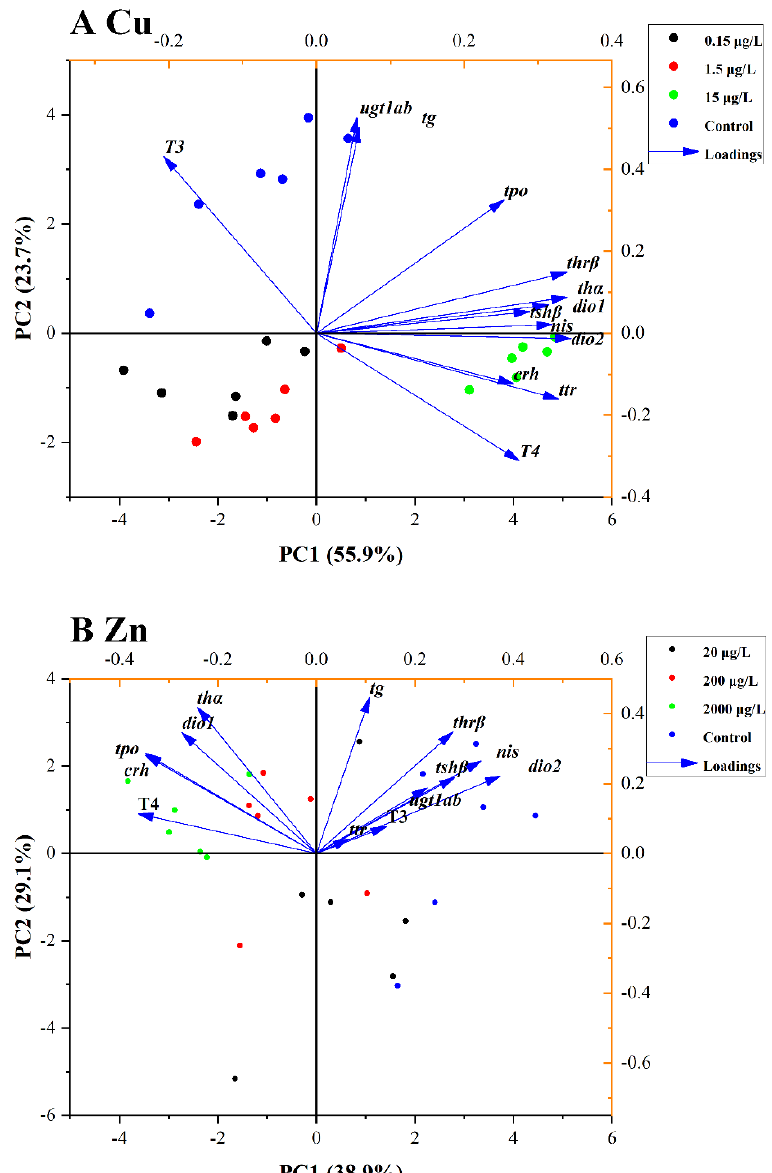
Figure 3. PCA of parameters in zebrafish embryos/larvae that were treated with Cu 2+ (0, 1.5, 15 and 150 µ g/L) ( A ) and Zn 2+ (0, 20, 200 and 2000 µ g/L) ( B ) for 120 h. The PCA result of Zn 2+ exposure is shown in Figure 3B. The initial two PCs explained 68.0% of the total variances. The PC1 accounted for 38.9% of the total variances, while PC2 explained 29.1% of the total variances. Based on the PCA result, the separation between clusters of control and 200 and 2000 µ g/L Zn 2+ groups were significant. T4 level were seen to be significantly and positively correlated with the transcriptional levels of crh , tpo , th α and dio1 and were negatively related to the transcriptional levels of nis , thr β and dio2 (Figure 4B), while there was a strong positive correlation between T3 level and thr β transcriptional levels (Figure